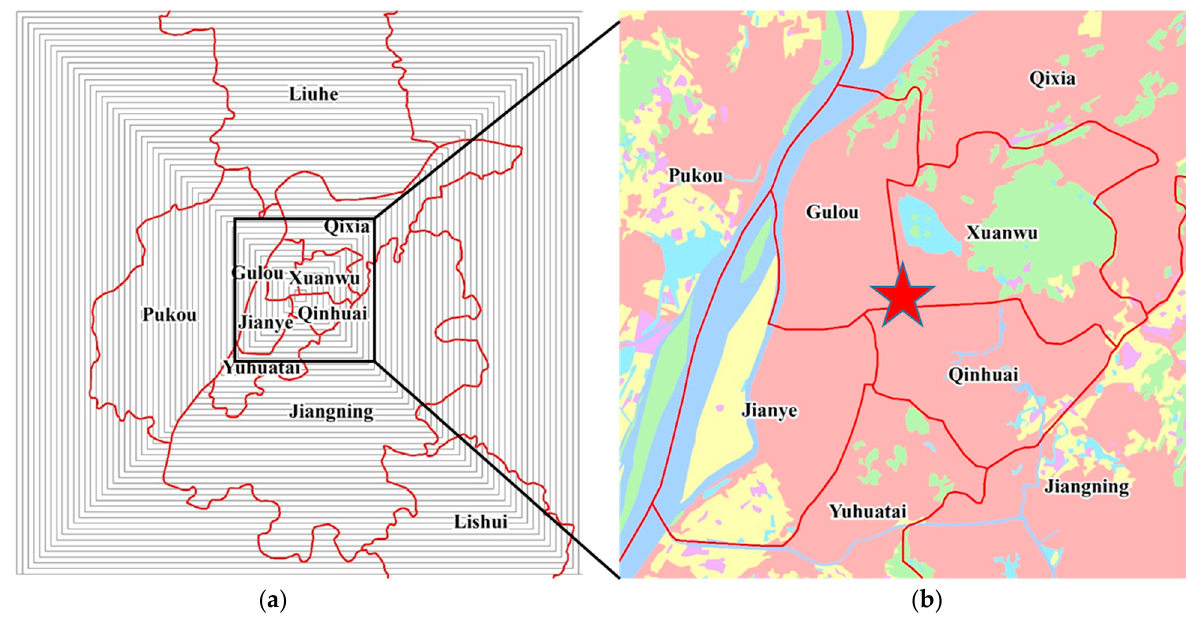
Figure 5. Square layers construction for Nanjing. ( a ) Square layers inside the urban area; ( b ) Central point of Nanjing.